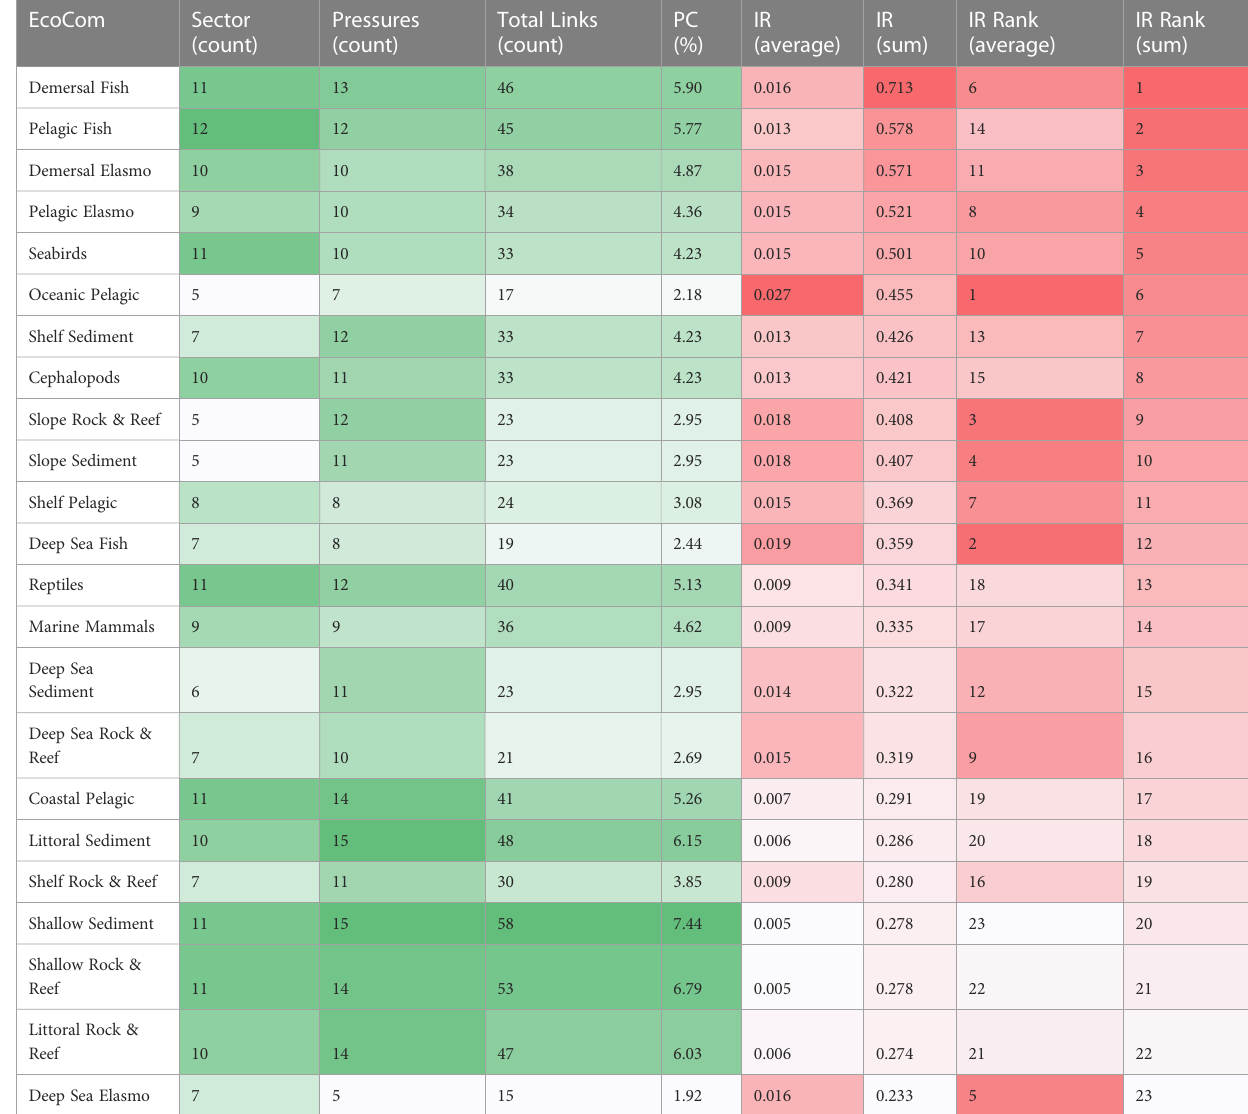
TABLE 6 Rankings of descriptors identi fi ed by the summed and average impact risk (IR) and their proportional connectance (PC), and sum and average risk scores for Ecological components (EcoCom).